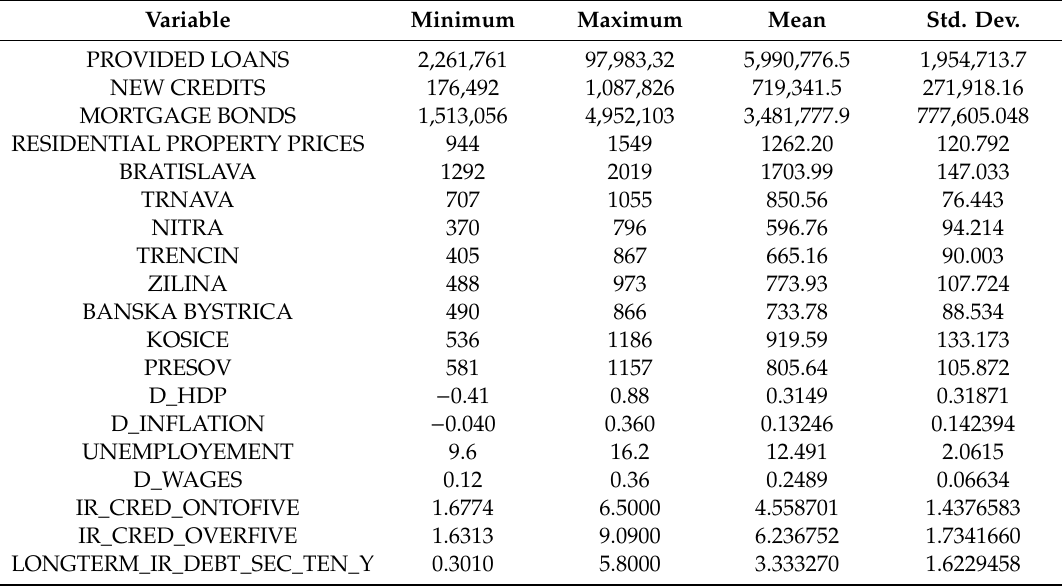
Table 1. Variables and descriptive statistics of Slovak mortgage banking development during the period 2006–2017.